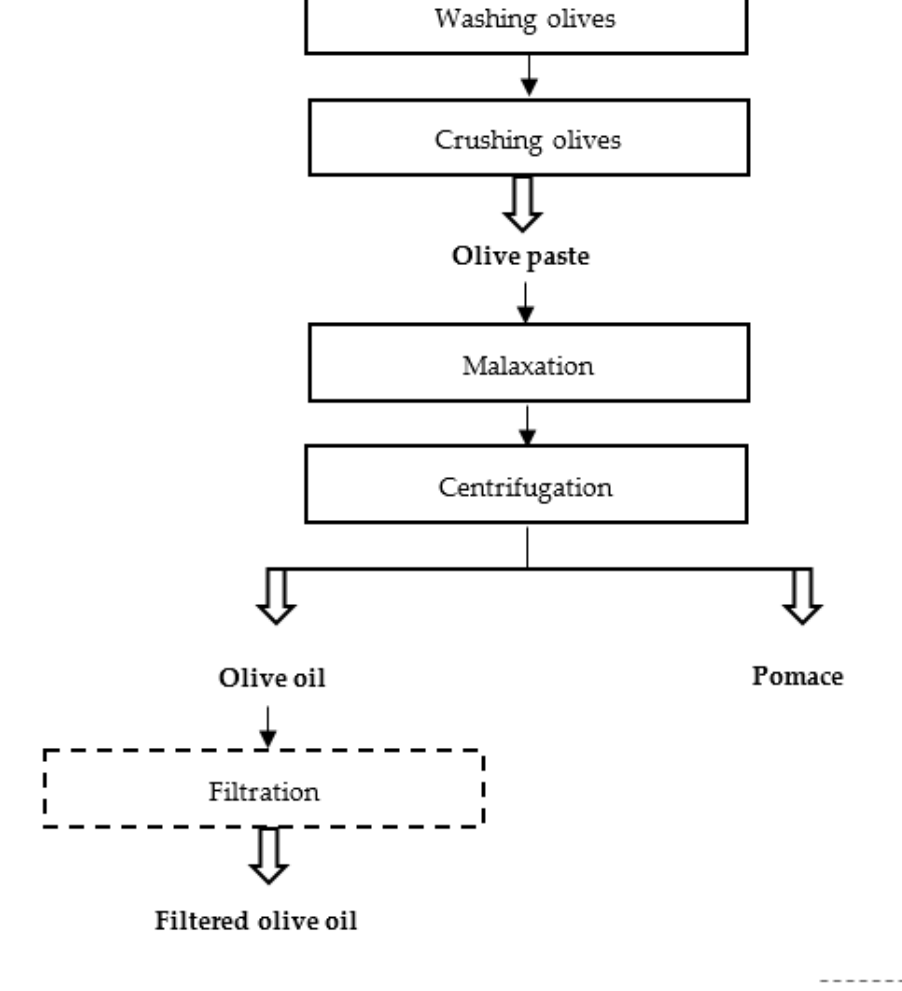
Figure 1. The continuous extraction process of olive oil.